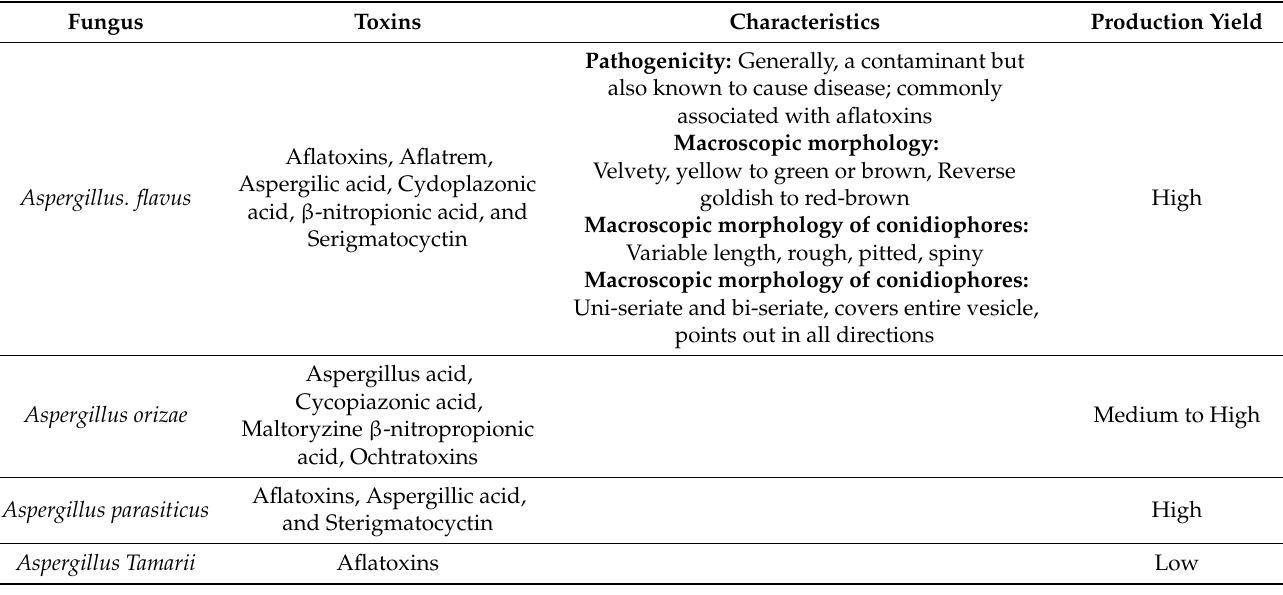
Table 1. Production of KA. Adapted from Chaudhary, 2014 [10].